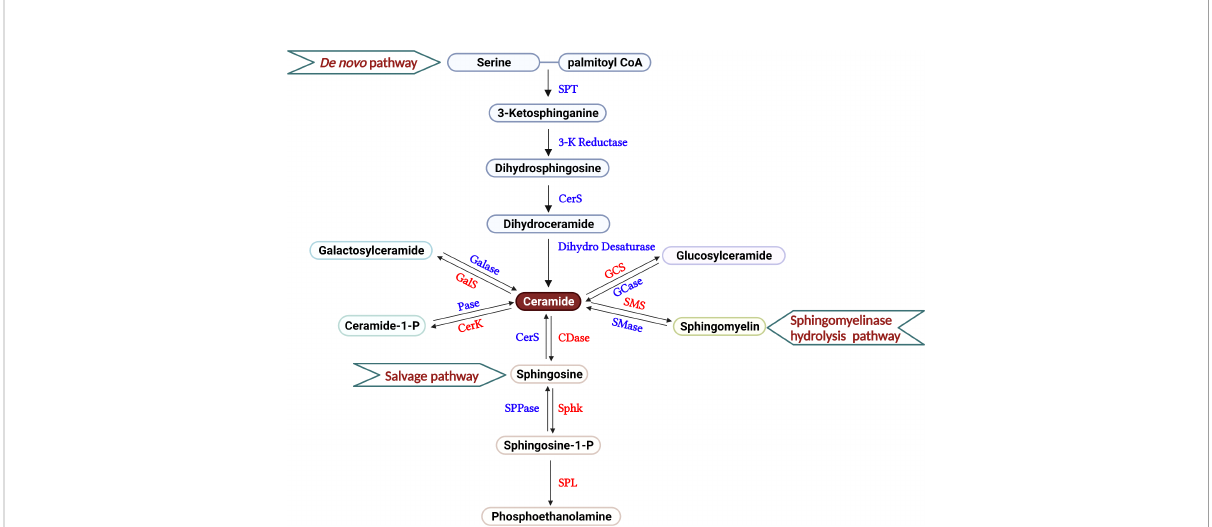
FIGURE 1 Overview of sphingolipid metabolism. The three different pathways that produce the sphingolipids in T cells are described, including de novo generation, salvage, and sphingomyelinase hydrolysis pathways. In the current review, the roles of galactosyl ceramide, ceramide and S1P are primarily discussed in the regulation of T cell-mediated GVH and GVL responses after allo-HCT. Serine Palmitoyl Transferase (SPT), 3- Ketosphinganine Reductase (3-K Reductase), Ceramide Synthase (CerS), Dihydroceramide Desaturase (Dihydro Desaturase), Ceramidase (CDase), Sphingosine Phosphate Phosphatase (SPPase), Sphingosine kinase (Sphk), S1P Lyase (SPL), Galactosyl ceramidase (Galase), Galactosylceramide synthase (GalS), Phosphatase (Pase), Ceramide Kinase (CerK), Glucosyl ceramidase (GCase), Glucosylceramide synthase (GCS), Sphingomyelinase (SMase), Sphingomyelin synthase